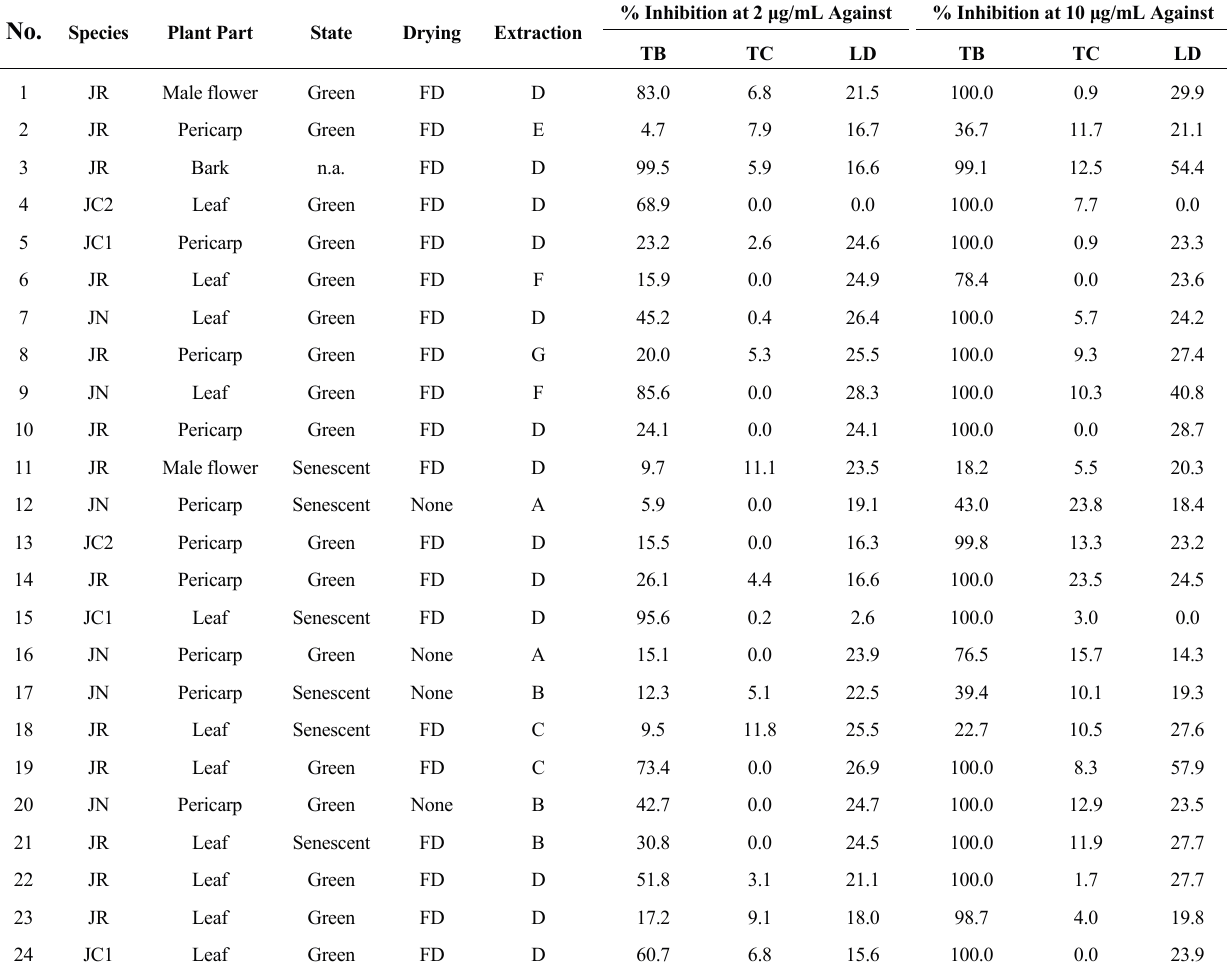
Table 1. Bioactivities of different extracts from Juglans regia (JR), Juglans cinerea (JC1 and JC2) and Juglans nigra (JN) against Trypanosoma brucei rhodesiense